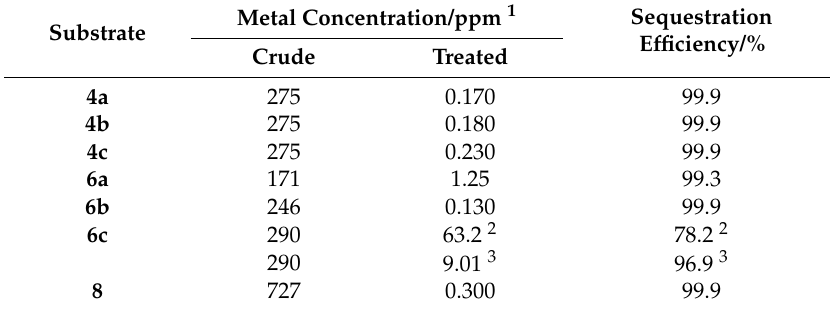
Figure 2. Qualitative visual photographs showing the results of Pd sequestration from crude compounds 4a,b. Table 3. Results of palladium/copper sequestration from model reaction mixtures.